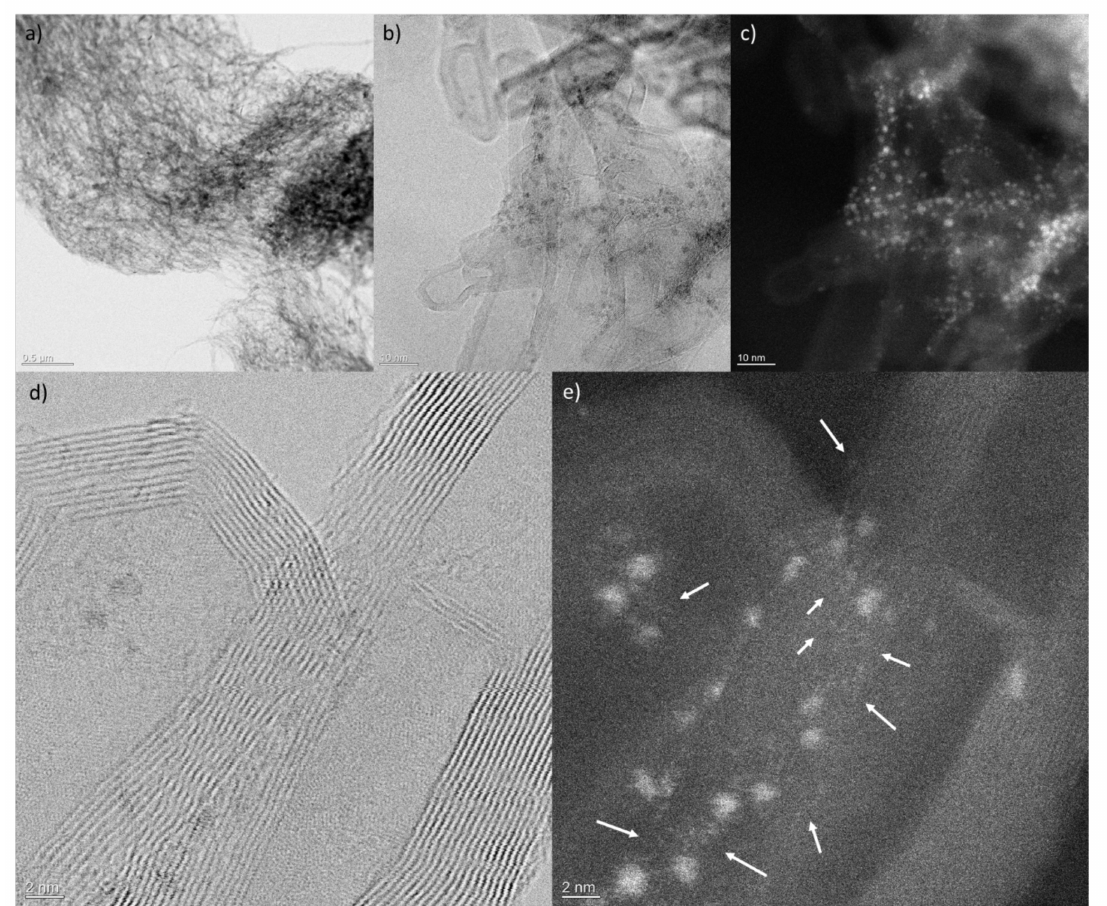
Figure 8. Scanning Transmission Electron Microscopy (STEM) images of as deposited sample. ( a ) Overview BF image showing a bundle of multi-walled carbon nanotubes (MWCNTs); ( b ) higher magnification BF stem image showing the MWCNTs and the Pd as dark patches. ( c ) High Angle Annular Dark Field (HAADF) Stem images showing Pd distribution as 2–3 nm clusters. ( d ) HR-BF STEM image showing MWCNTs crystallinity, and ( e ) HR-HAADF showing 2–3 nm and sub-nanometer clusters of Pd (indicated by white